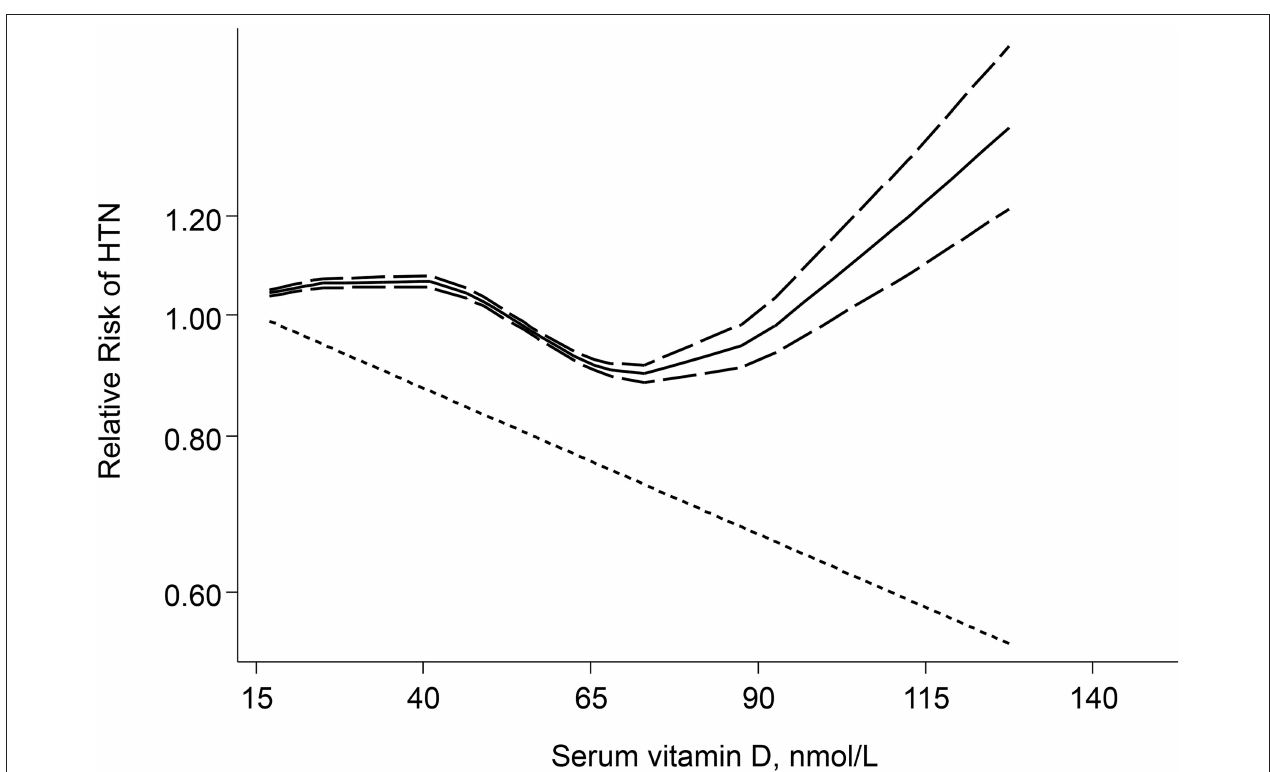
FIGURE 4 | Non-Linear dose–response meta-analysis of serum vitamin D and risk of HTN in prospective